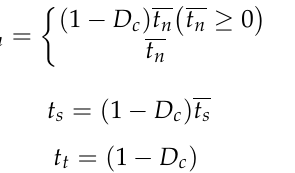
Figure 8. Flow chart of simulation procedure between 2D Hashin and 3D Hashin VUMAT models.